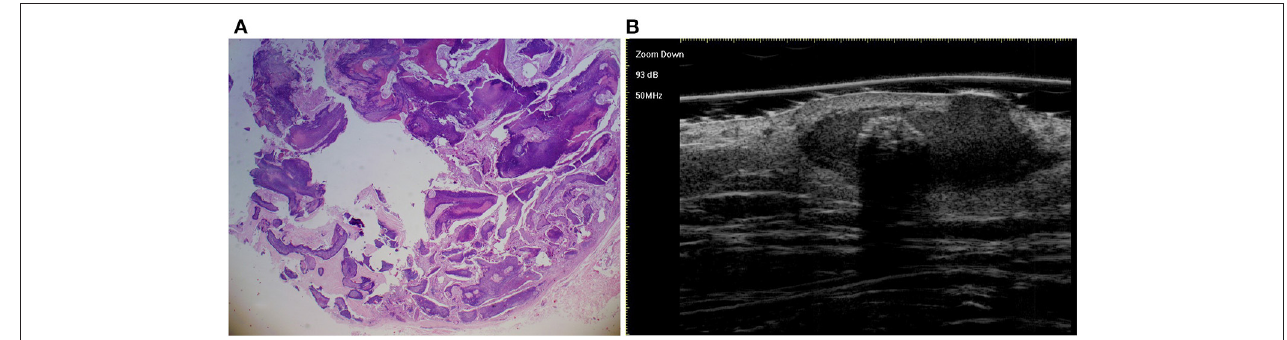
FIGURE 6 | The histological presentation [ (A) HE, original magnification × 25] and ultra-high frequency ultrasound (B) of PM in the early regressive stage, indicating arc calcification. TABLE 1 | Ultra-high-frequency ultrasonographic features in various histological stages. Ultrasound